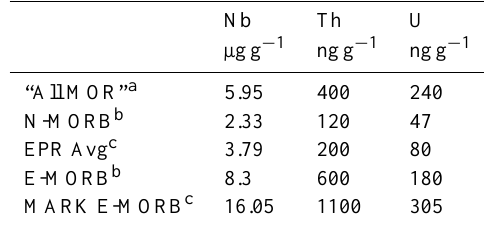
Table 2. Average MORB